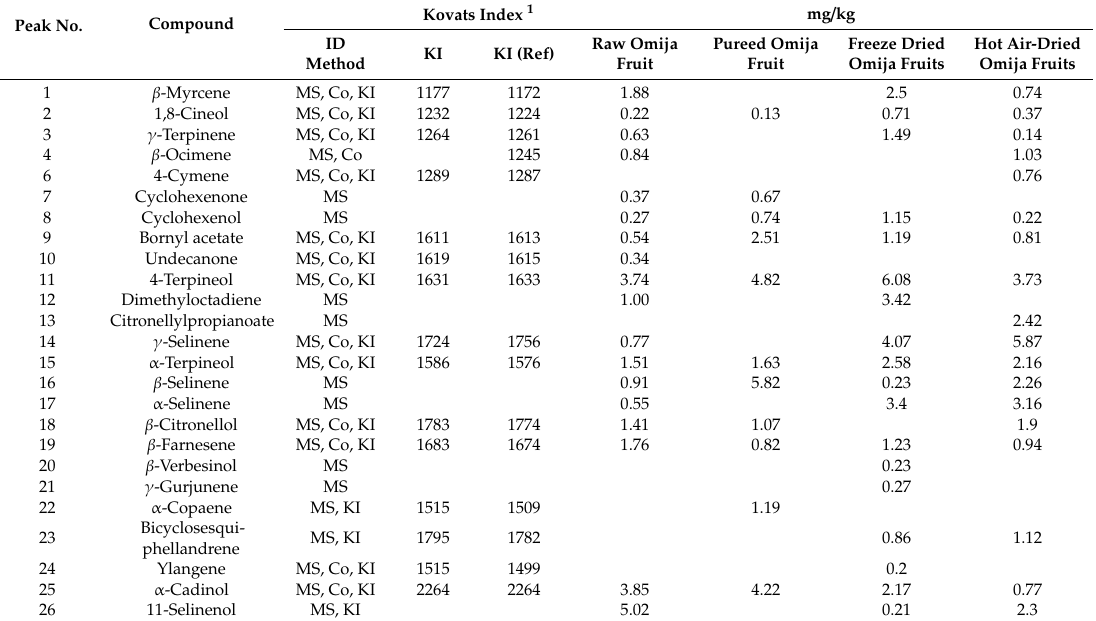
Table 1. Instrumental flavor analysis results of omija fruit extracts. Peak